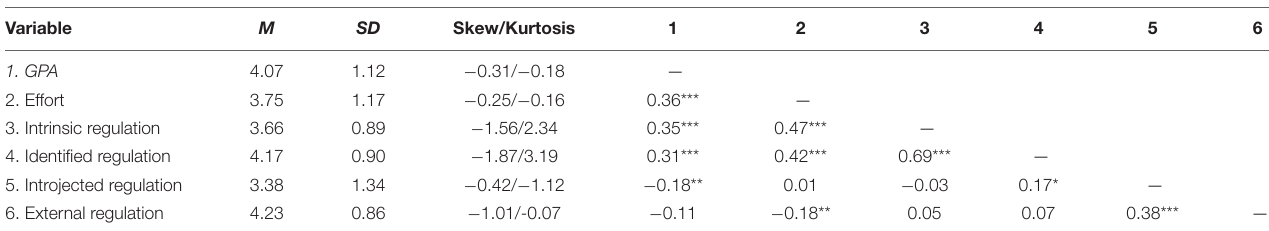
TABLE 1 | Descriptive statistics and zero-order correlations for the variables. Variable M